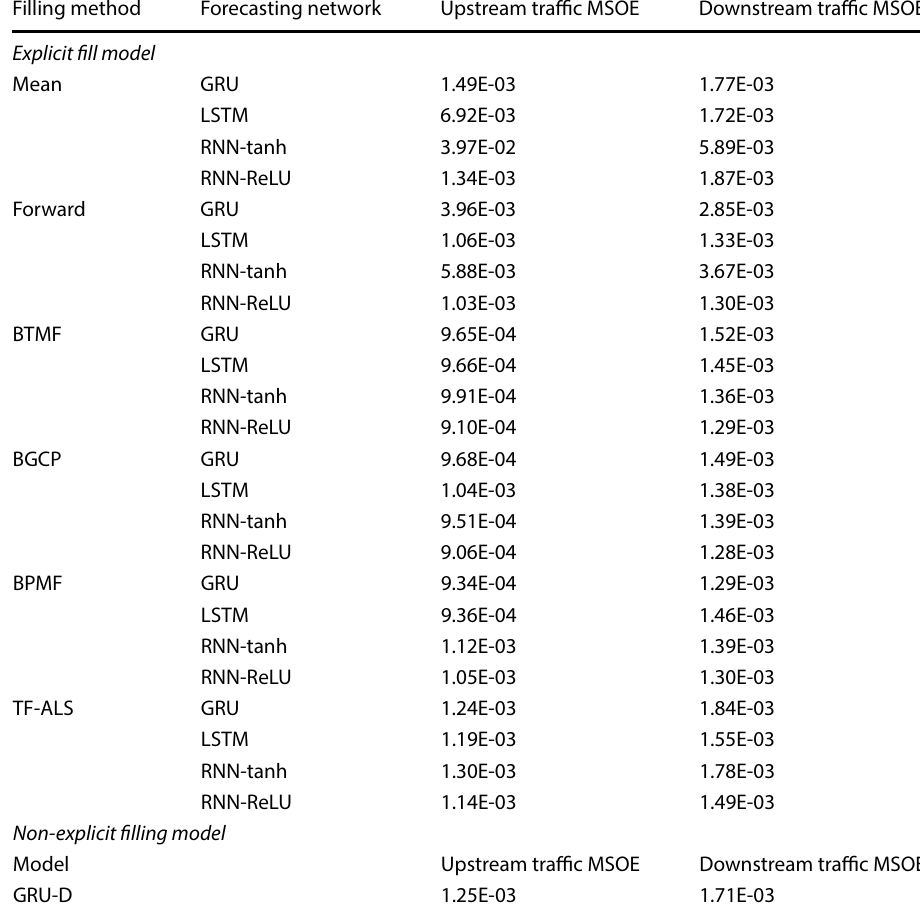
Table 6 Model comparison experiment results